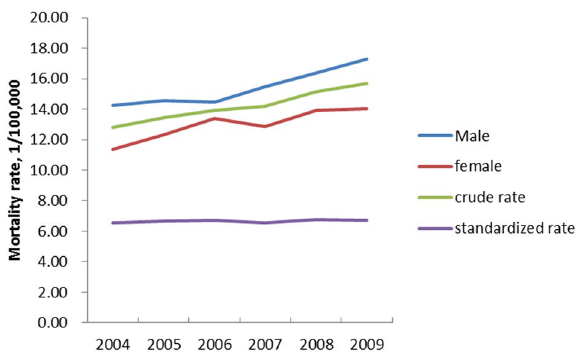
Figure 1. The incidence rate of pancreatic cancer of Shanghai residency during 2004 – 2009 (1/100,000).